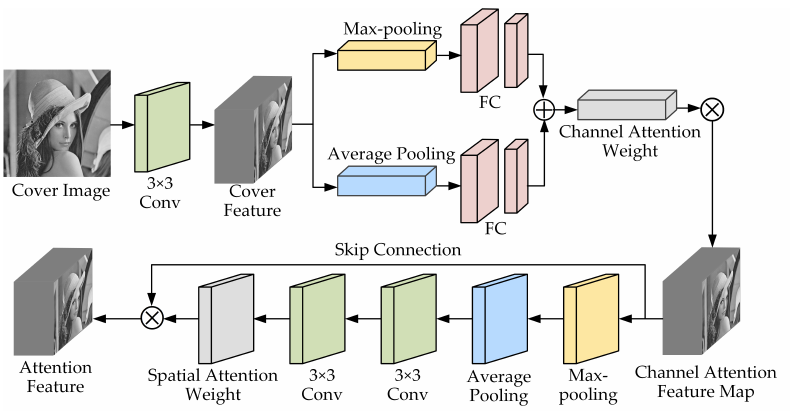
Figure 2. Attention network: preprocessing of the cover